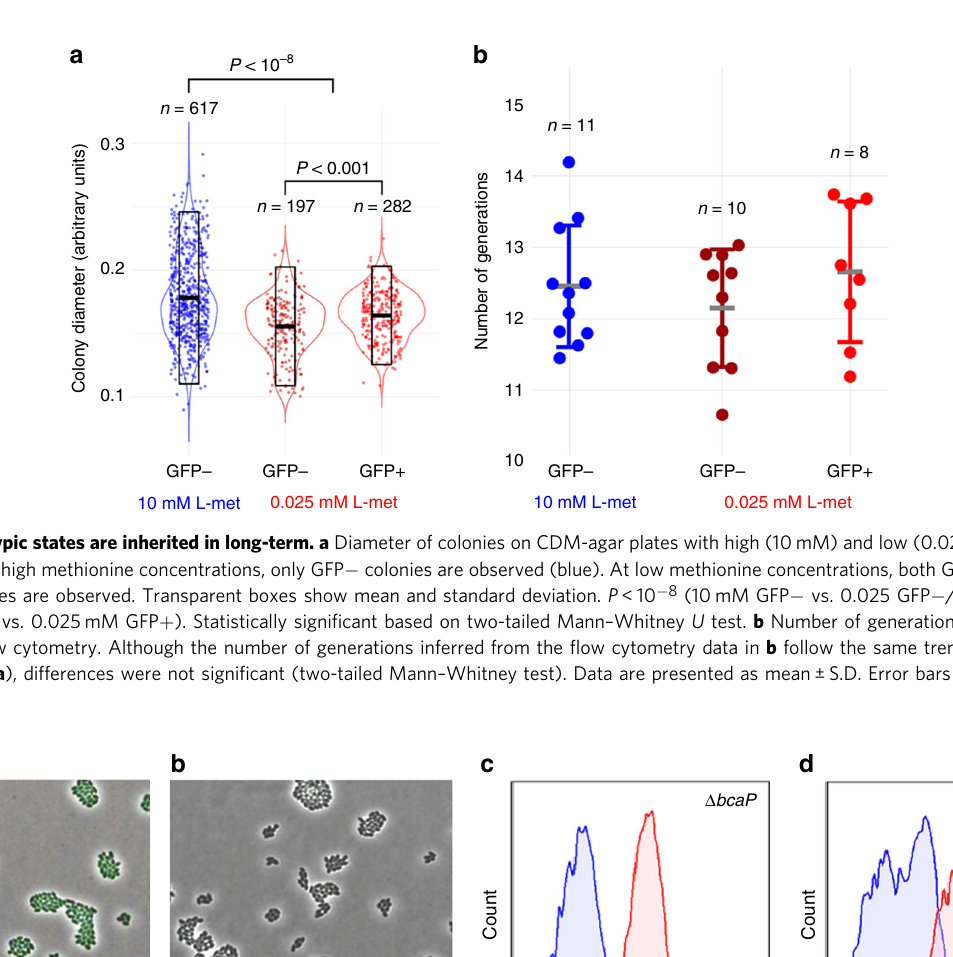
af fi nity transporter. To test this, we constructed a codY knockout mutant. CodY is a transcriptional repressor of bcaP 20 . Its knockdown therefore increases the expression of the low-af fi nity transporter. As expected, the codY knockout mutant shows a decreased met expression (Supplementary Fig. 11), thereby con- fi rming that the low-af fi nity transporter can directly compensate for the high-af fi nity transporter.